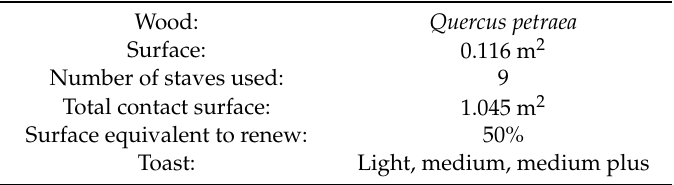
Table 3. Characteristics of the added staves.